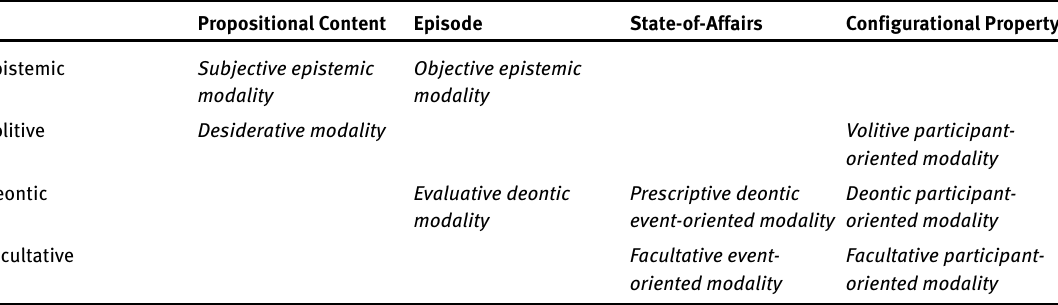
Table 1 : Modal subcategories in